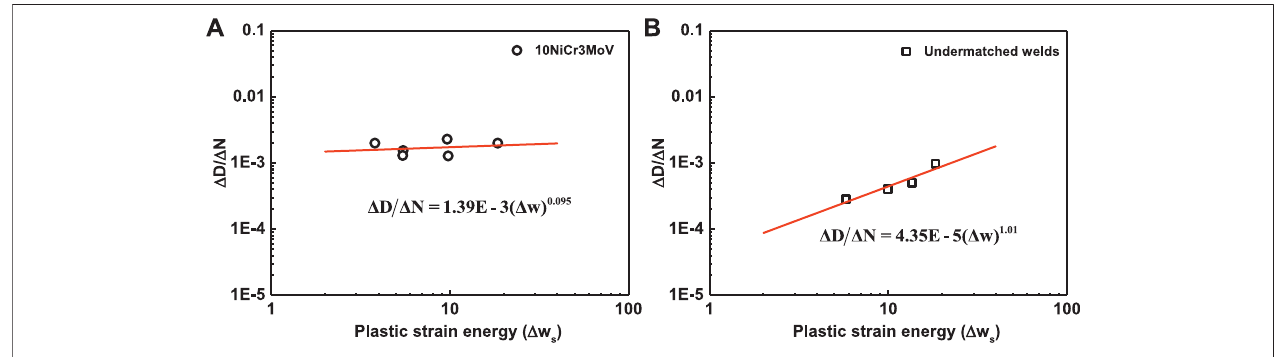
FIGURE 13 | The log – log relationship of Δ w 0 and damage values in the degradation stage. (A) 10CrNi3MoV steel and (B) undermatched welds.